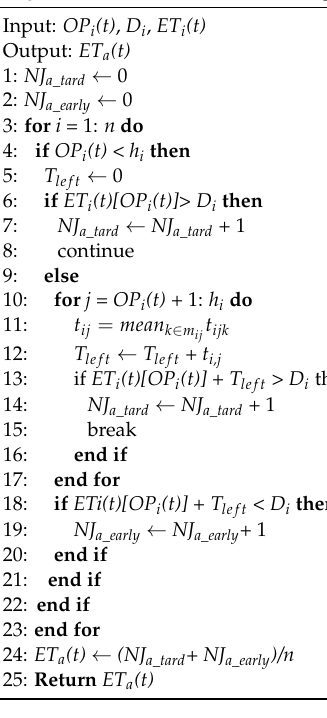
Algorithm 2 Procedure of calculating the actual earliness and tardiness rate ET a ( t )